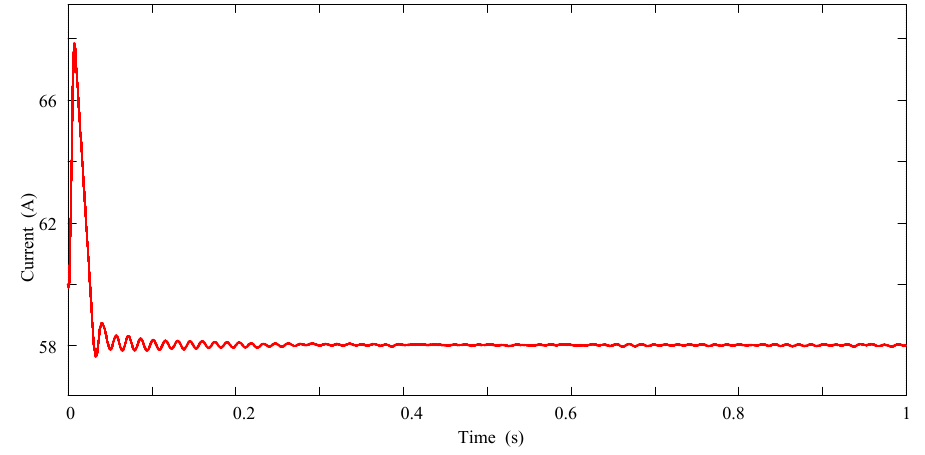
Figure 14. Output voltage of a DC microgrid with three non ‐ identical converters.